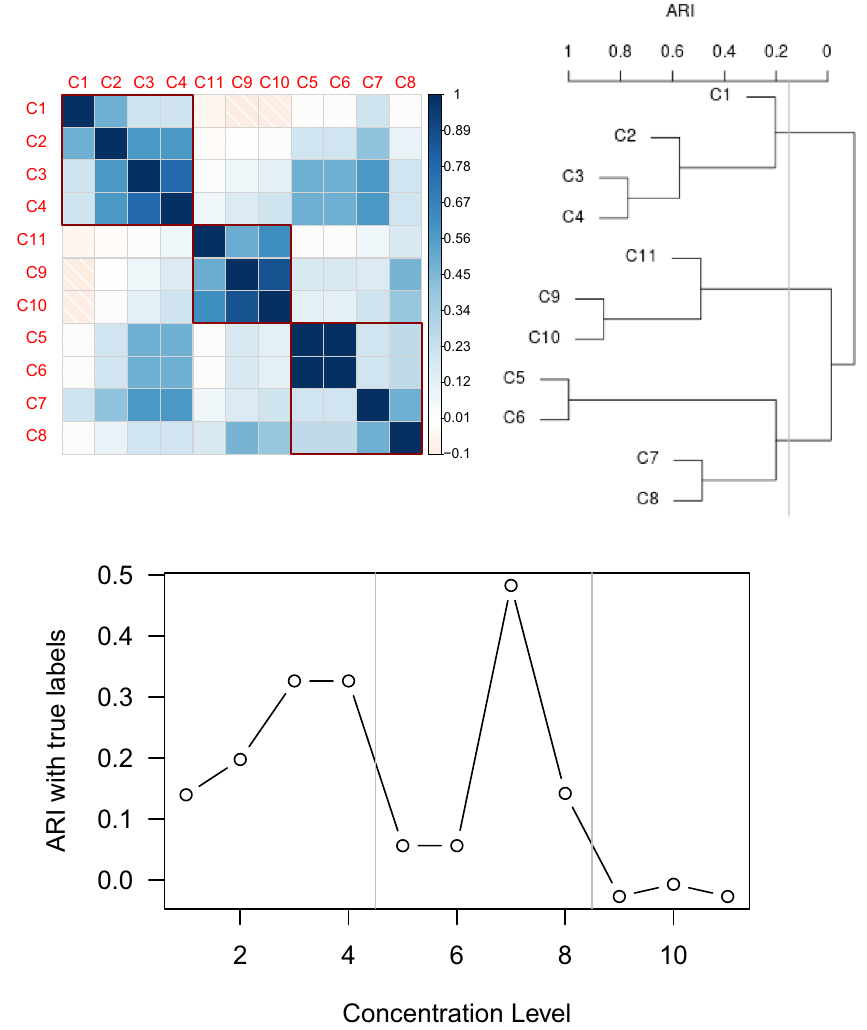
Figure 2. On the top left is a plot of ARI values comparing pairwise k-means clustering similarity between the 11 concentration levels. The red boxes indicate hierarchical clustering of the concentration levels based on ARI using complete linkage. On the top right, is the cluster dendrogram corresponding to the ARI value. The bottom plot charts the ARI values for similarity between k-means cluster assignment and the true